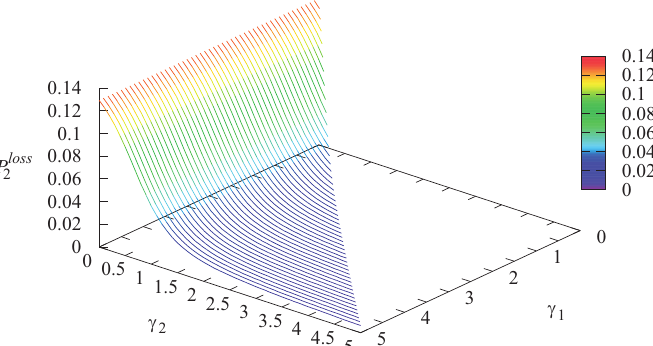
of an arbitrary non-priority customer loss from Storage 2 2